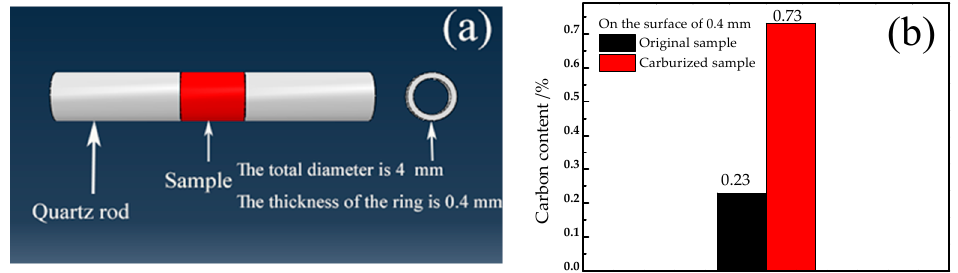
Figure 1. ( a ) Quartz push-rod diagram, ( b ) carbon content of the carburised sample and the origi- nal sample.